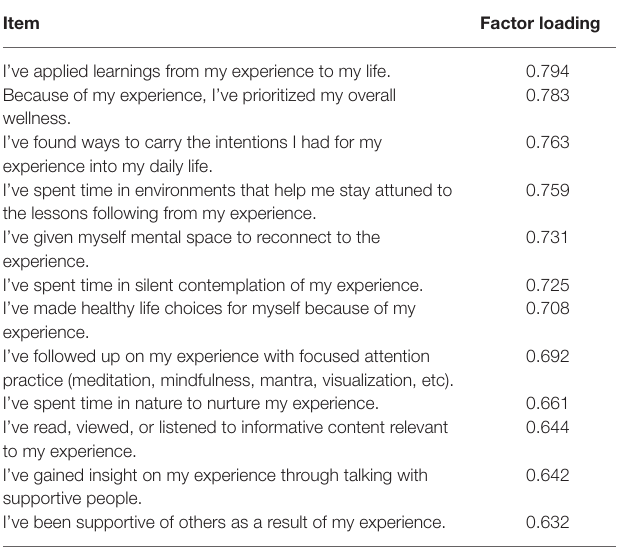
TABLE 8 | EFA component matrix for the integration engagement scale.